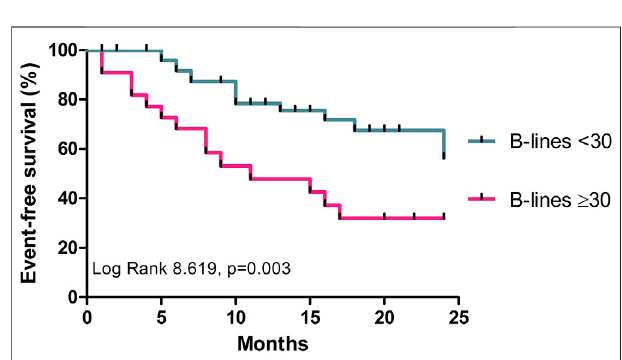
FIGURE 3 | Comparison of HF endpoints among patients with ≥ 30 and < 30